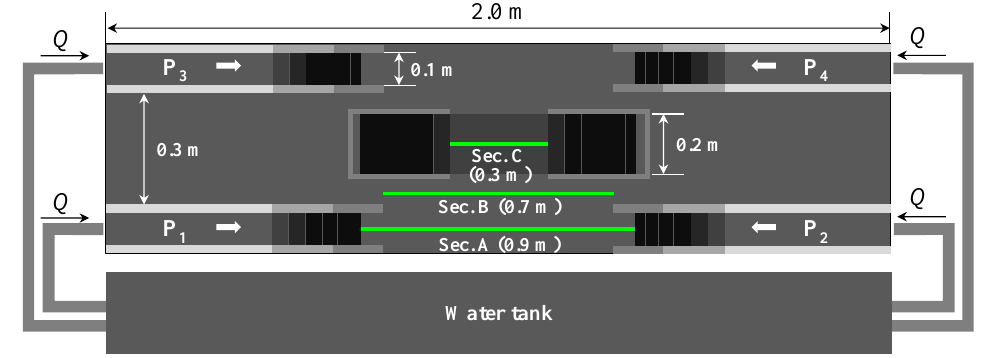
Figure 2. Plan view of the subway station model.